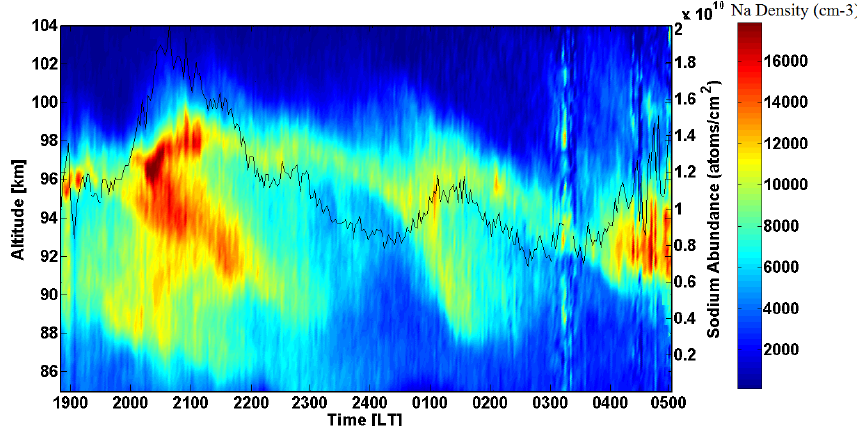
Fig. 4. Contour plot of sodium density layer observed for the night of 15/16 January 2006 and the abundance (solid line) for the same day in the figure.